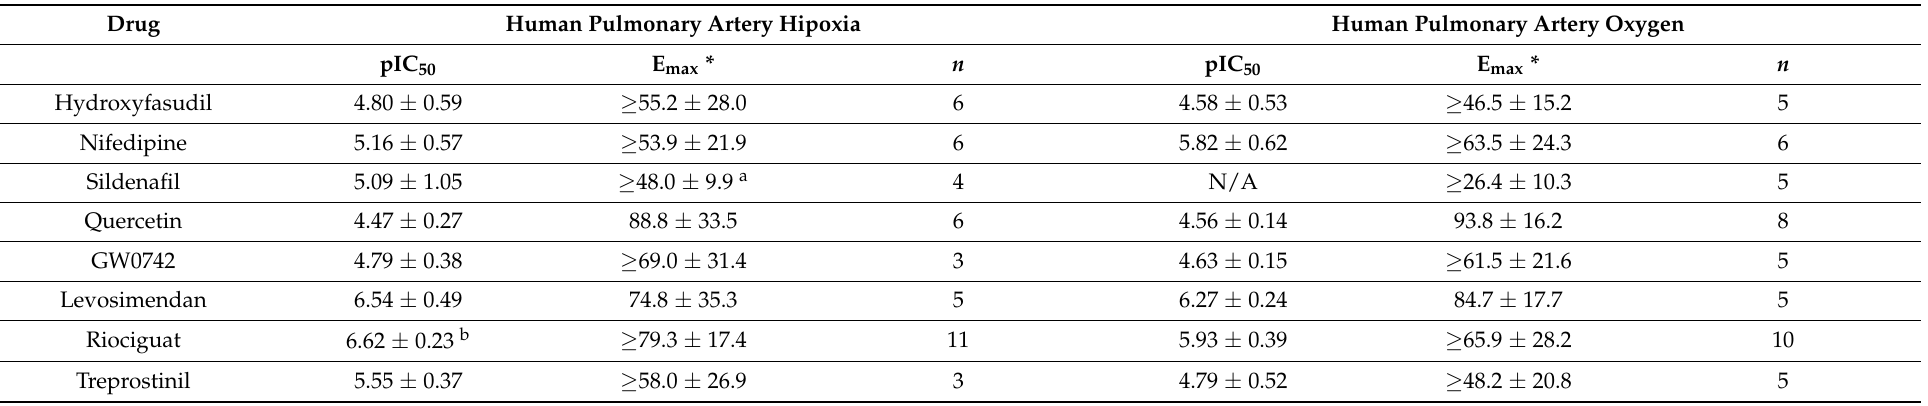
Table 2. Parameters derived from the concentration-response curves in human pulmonary arteries under hypoxia or oxygen